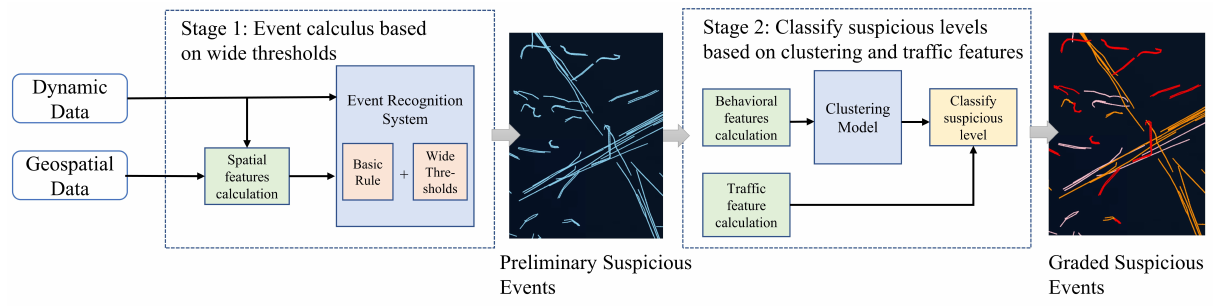
Figure 1. Overall methodology framework of the proposed transshipment identification